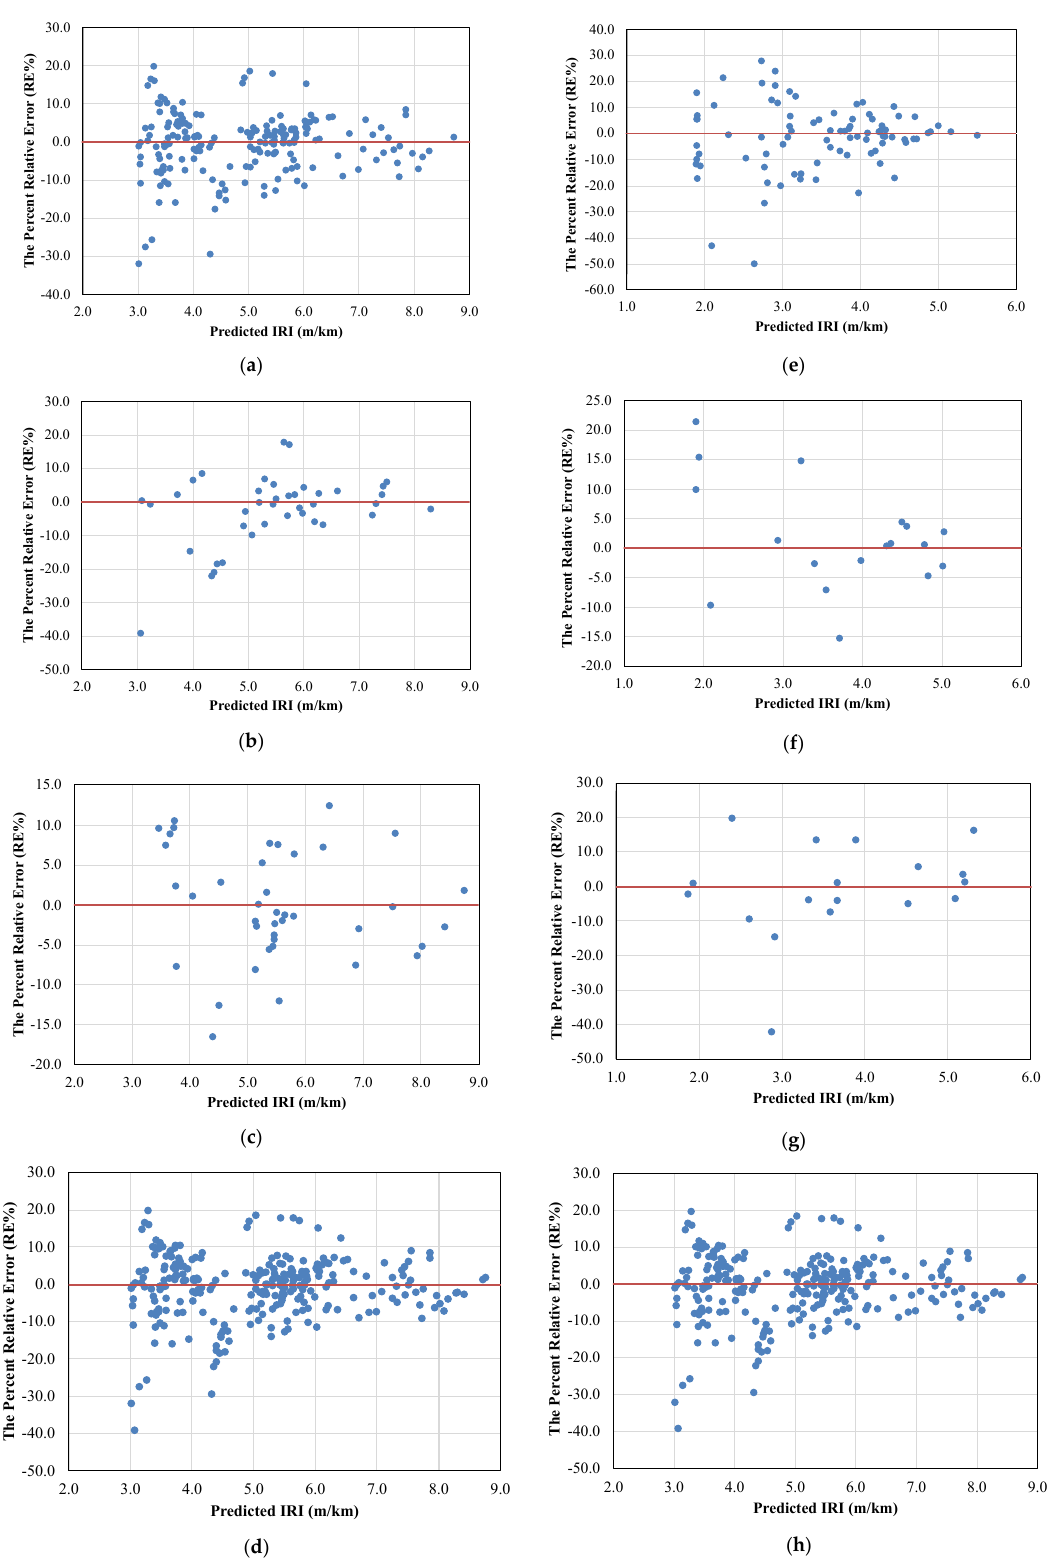
Figure 16. The RE% for the training, checking, testing, and overall datasets of DBST and AC models. ( a ) Training dataset for DBST Model, ( b ) Checking dataset for DBST Model, ( c ) Testing dataset for DBST Model, ( d ) Overall dataset for DBST Model, ( e ) Training dataset for AC Model, ( f ) Checking dataset for AC Model, ( g ) Checking dataset for AC Model, ( h ) Checking dataset for AC Model.